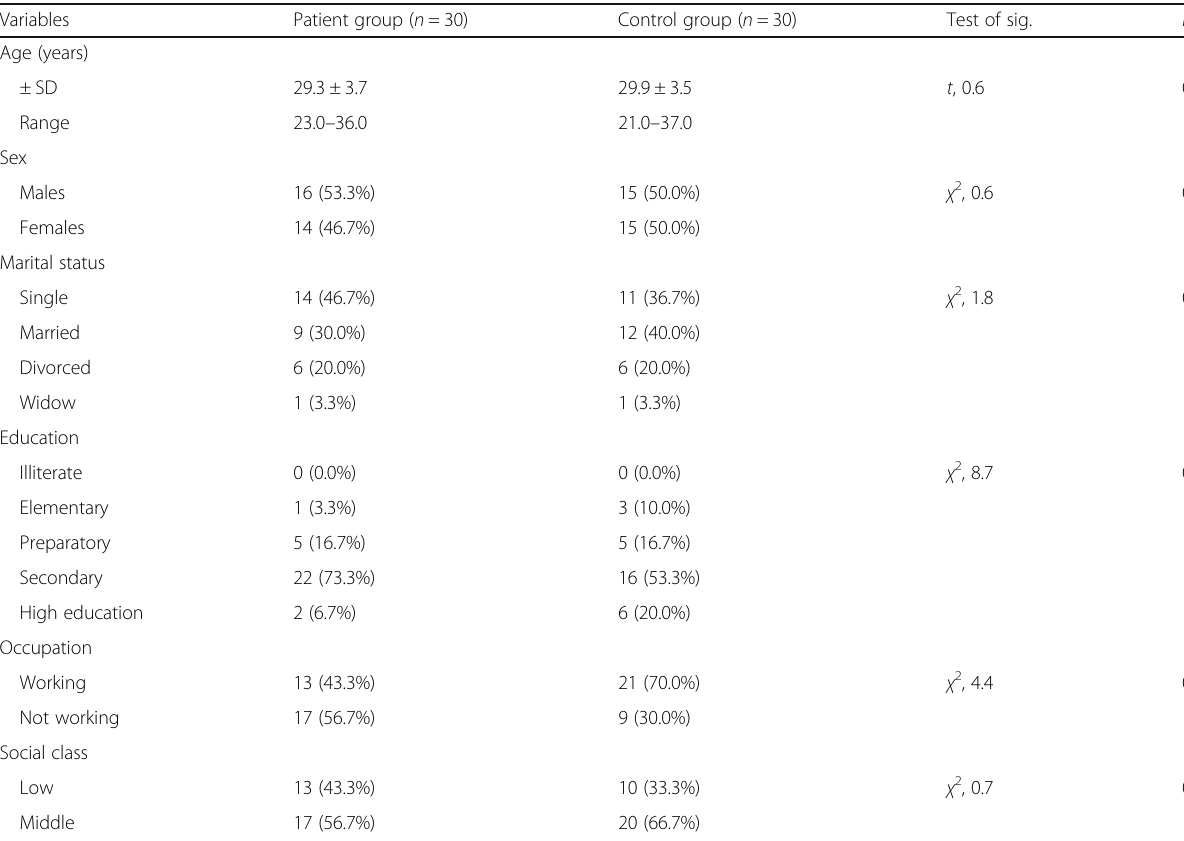
Table 1 Demographic characteristics of the studied groups